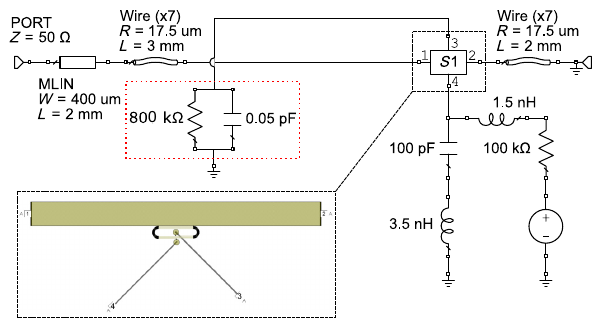
FIG. 8. AWR AXIEM EM simulations. We model the system, including parasitic contributions, using a three-dimensional pla- nar MOM EM analysis simulator. The insert shows the model of the sapphire chip with the microstrip waveguide and spiral inductor. The NWFET is represented by a 800-k (cid:4) resistor in par- allel with a 50-fF capacitor, highlighted by a red dotted box. The MLIN component resides on the Rogers 4003C PCB.